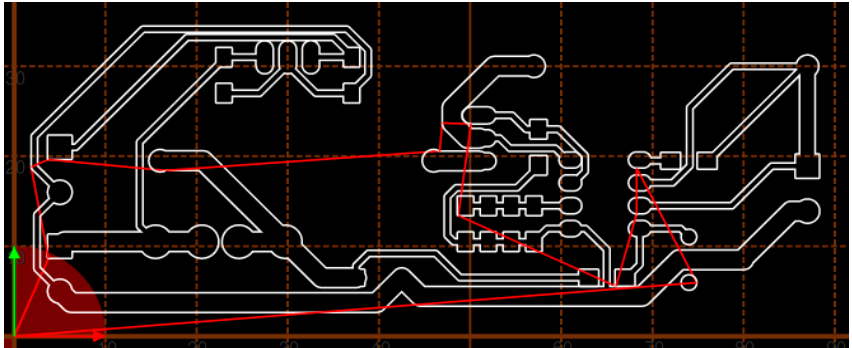
Figure 14. The resultant circuit board, which was milled on a 10° incline.